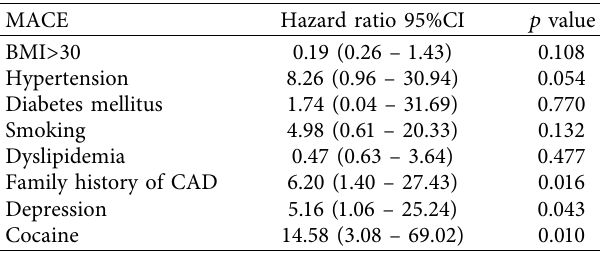
Table 5: Risk factors associated with MACE.